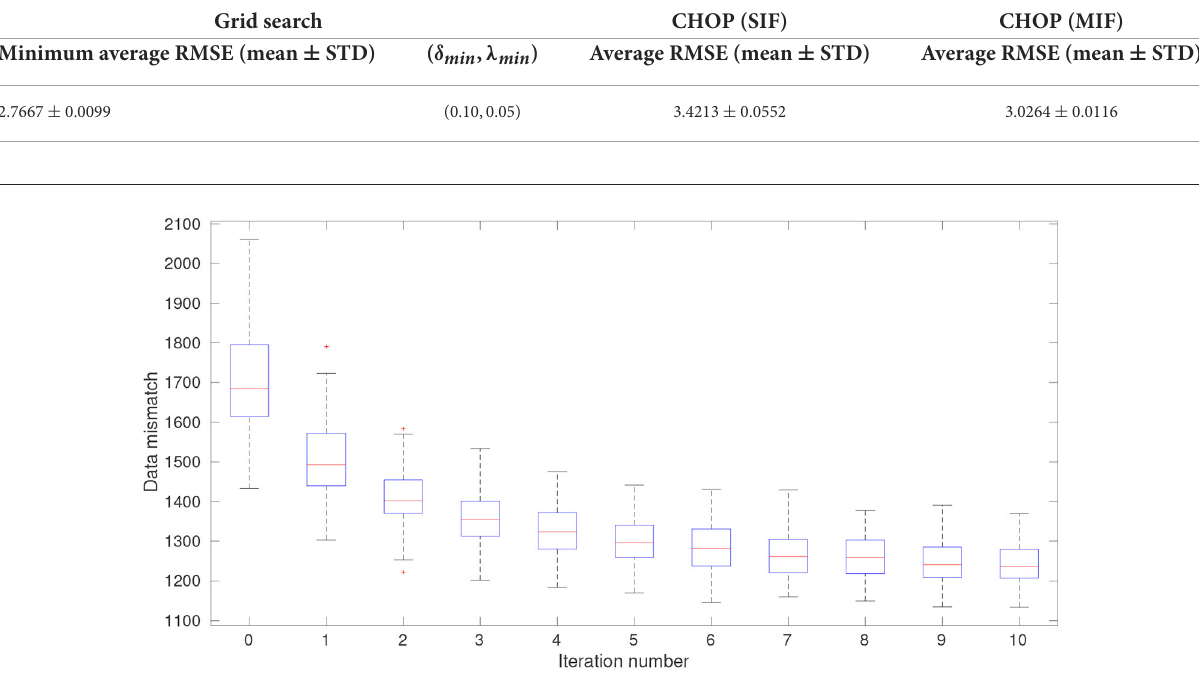
of updated model state variables at each iteration step. The data mismatch and RMSE values are then calculated with respect to the ensemble